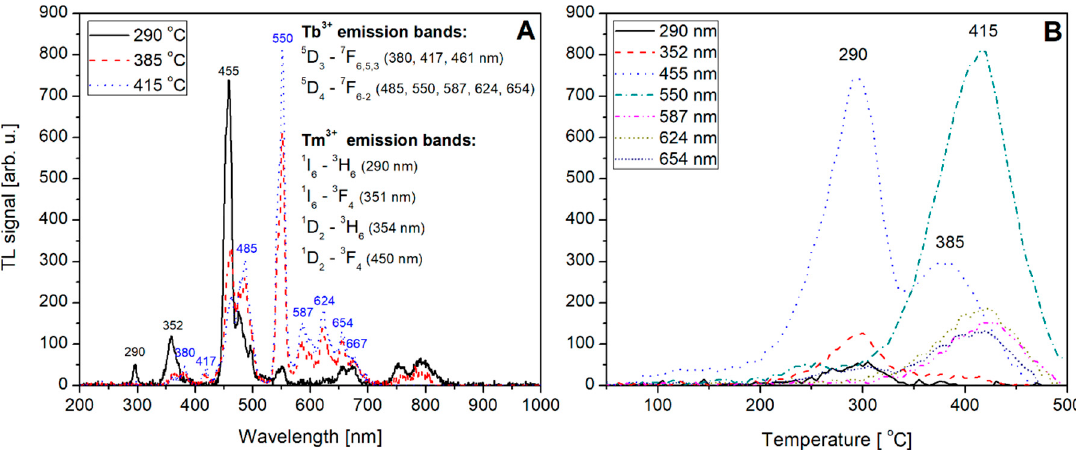
Figure 12. TL emission spectra (panel A ) measured for Tb (0.2), Tm (0.6) double doped LiMgPO 4 crystal at different temperatures corresponding to the glow-peaks maxima. TL glow-curves (panel B ) measured for the same Tb (0.2), Tm (0.6) double doped LiMgPO 4 crystal (irradiated with beta radiation) at different wavelengths corresponding to emission maxima.